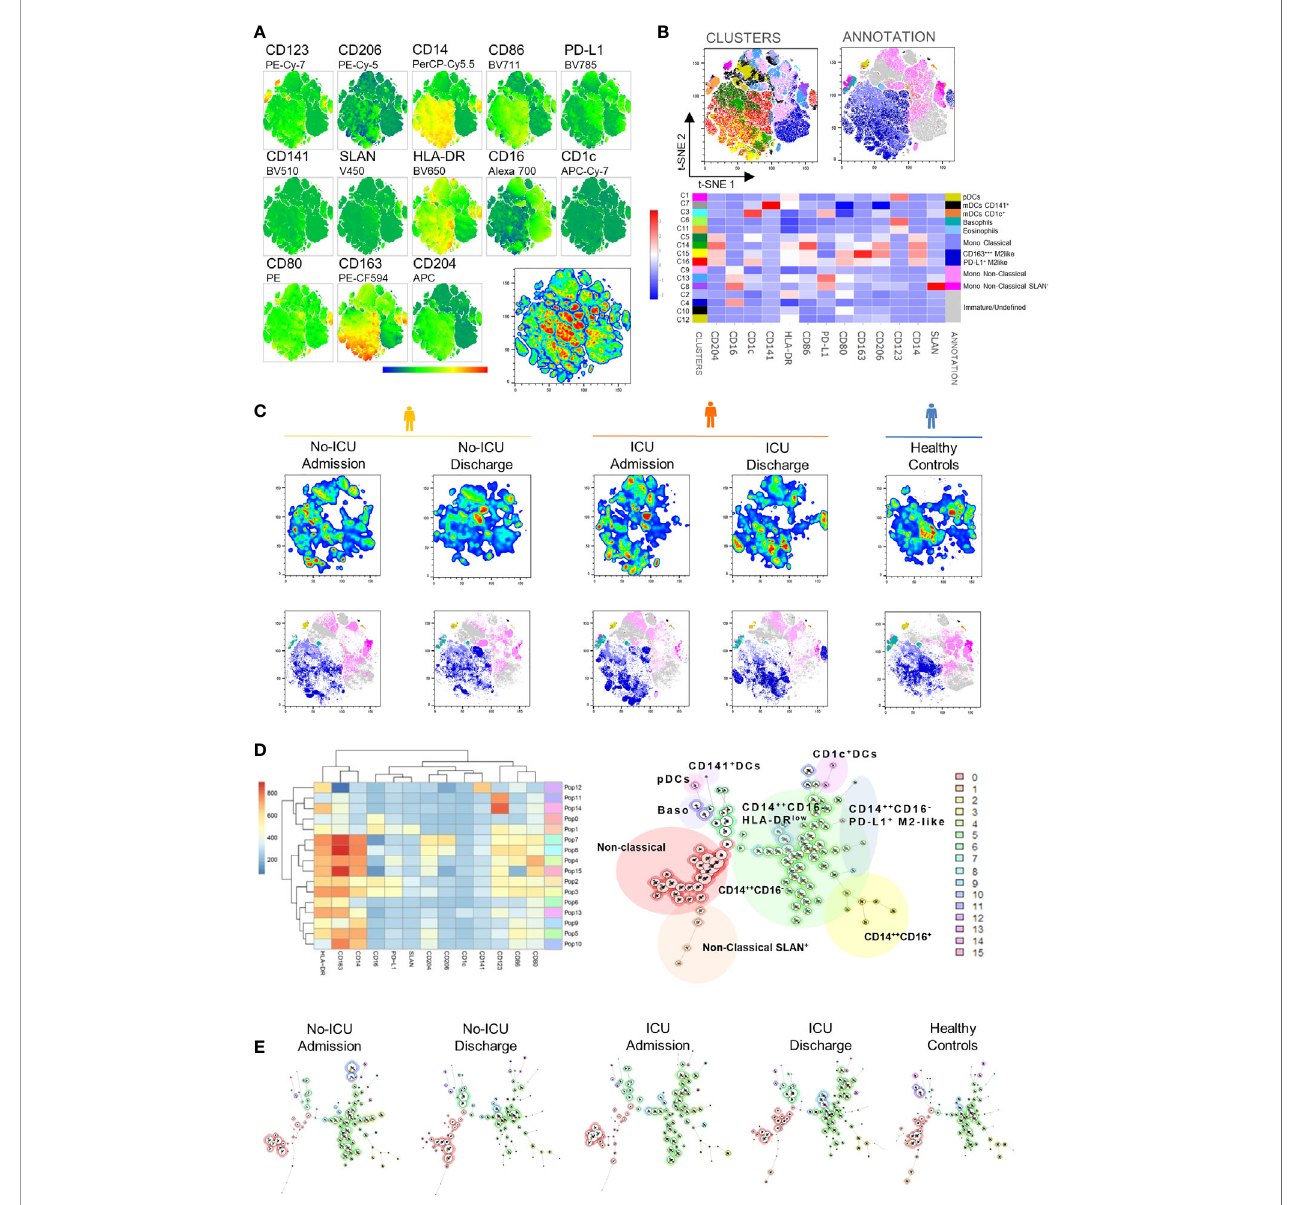
FIGURE 1 | Unsupervised analysis of myeloid cells in COVID-19 patients and healthy controls. (A) Dimensionality reduction performed by t-distributed Stochastic Neighbor Embedding (t-SNE) on concatenated CD45+Lin − cells from both time-points and from patient and control groups. Bi-dimensional plots of concatenated samples showing marker distribution. (B) Unsupervised clustering performed using X-shift. Bi-dimensional plots showing the 16 clusters obtained (left) and the manual annotation of the clusters (right). Heatmap showing the marker expression in the 16 X-shift clusters. (C) Cluster distribution in patients at admission/ discharge and in healthy controls. Bi-dimensional plots showing event density using pseudo-color (top) and cluster manual annotation (bottom). (D) Unsupervised clustering using FlowSOM. Heatmap showing relative marker expression (left) and self-organizing map with the obtained clusters (right). (E) FlowSOM cluster distribution in patients at admission/discharge and in healthy controls. Healthy controls (blue), No-ICU patients (yellow), and ICU patients